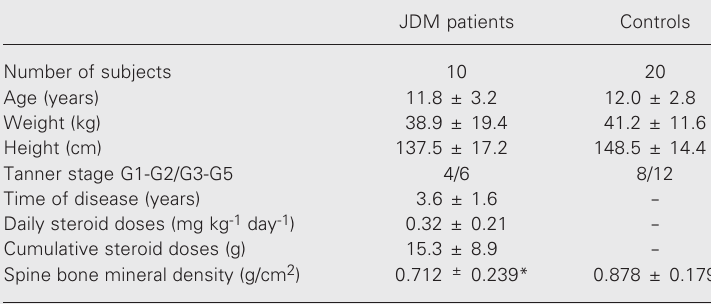
Data are reported as means ± SD. JDM = juvenile dermatomyositis. *P < 0.05 compared to controls (Student t